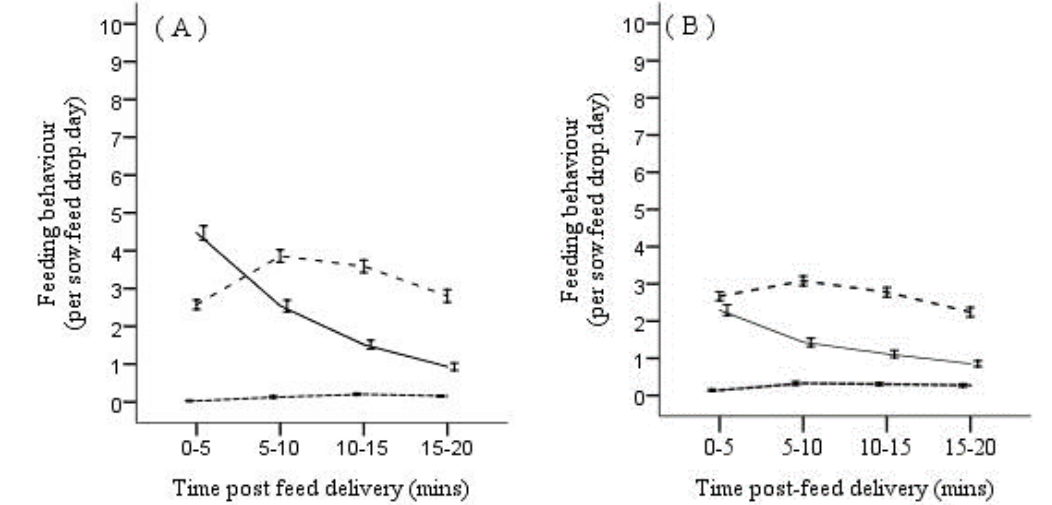
Figure 1. The average ( ± 95% confidence interval) number of times sows were recorded performing feeding behavior (per sow, feed drop and day) in areas of the pen associated with high ( ▬ ), reduced (- - -) and no (···) feed availability recorded over four, 5-min time periods immediately following feed delivery in gestations 1 ( A ) and 2 ( B ).